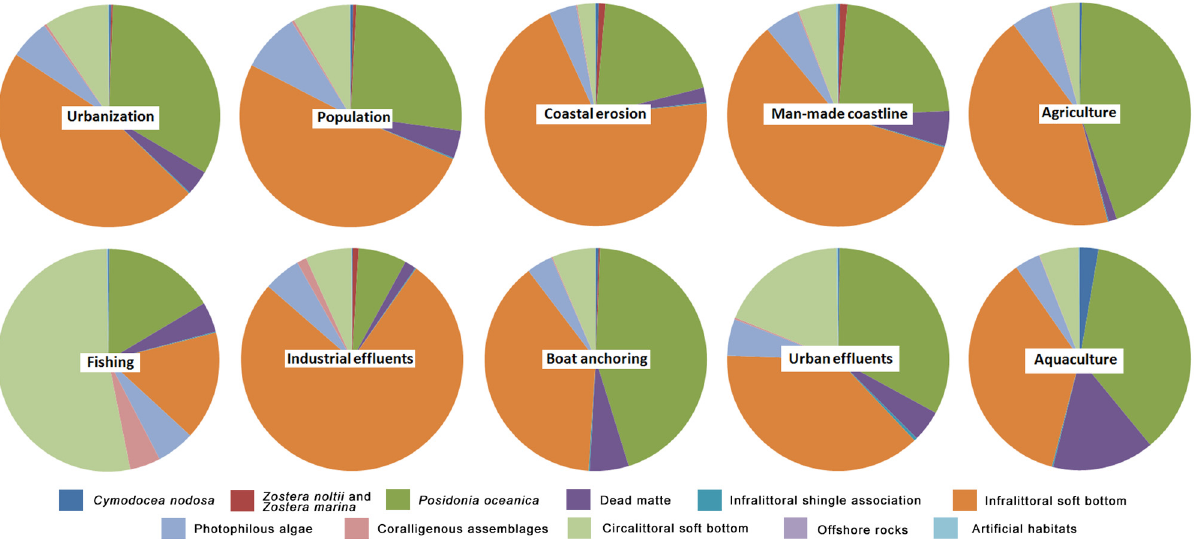
Fig 2. Repartition of the total cumulated value of each pressure in function of the habitats. Each pie chart indicates the repartition (in percent) of the total cumulated value (sum of all 20 x 20 m cell values concerning a pressure) of each individual pressure (name indicated in the white rectangles) in function of the